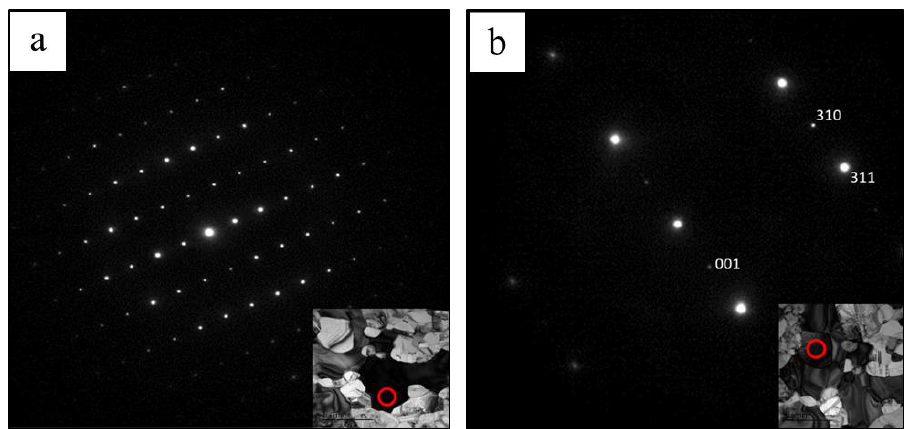
Figure 4. SAED analysis of the first and second domains as marked with red circles ( a , b ).